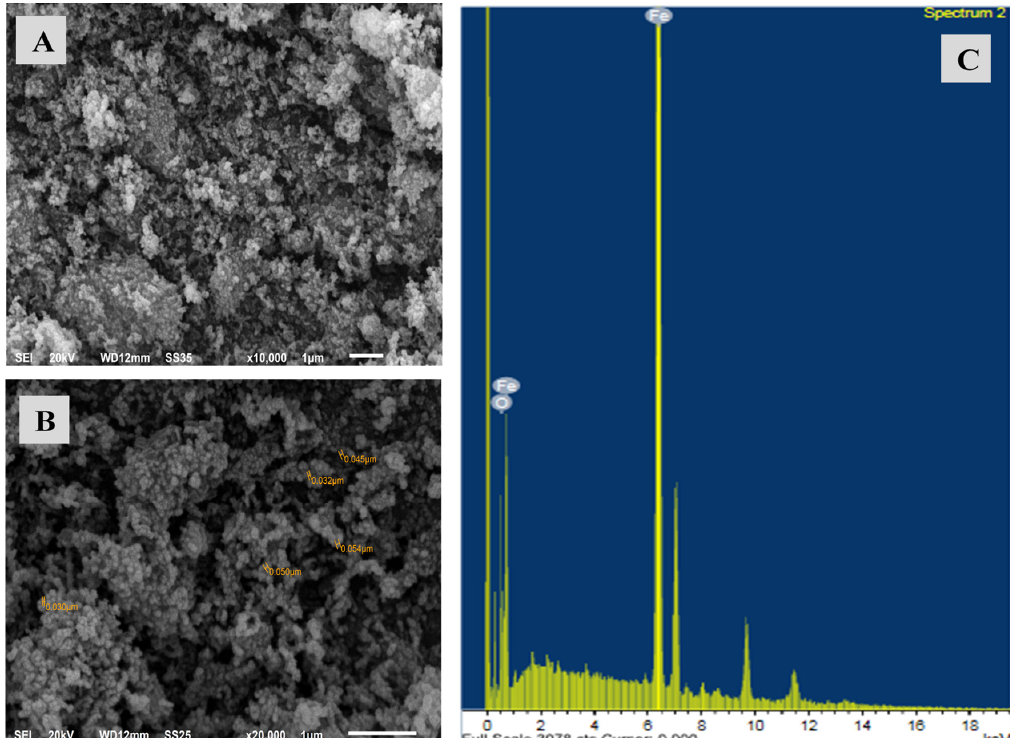
Figure 1. SEM micrographs at two different magnifications ( A , B ); EDX analysis of the prepared ZVI nanoparticles at optimum conditions ( C ).